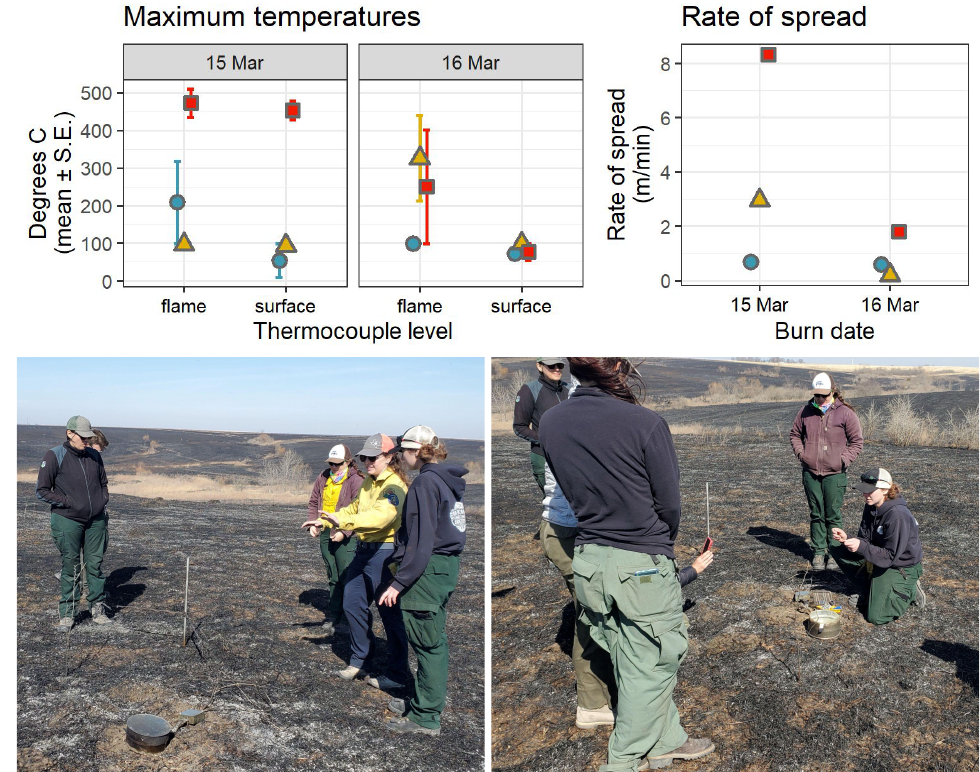
Figure 8. Top : Data retrieved from thermocouple dataloggers deployed at three locations in two different burn units at the Dunn Ranch Prairie. Data include flame temperatures measured 15 cm above the soil surface, and soil heating at the soil surface. Bottom : After Dr. Wonkka worked with squad leaders to understand how the thermocouple system had performed during the fire event ( L ), squad leaders then briefed the remainder of the crew ( R ). This constituted a contemporary, facilitated application of the “see one, do one, teach one” principle that balances autonomy and